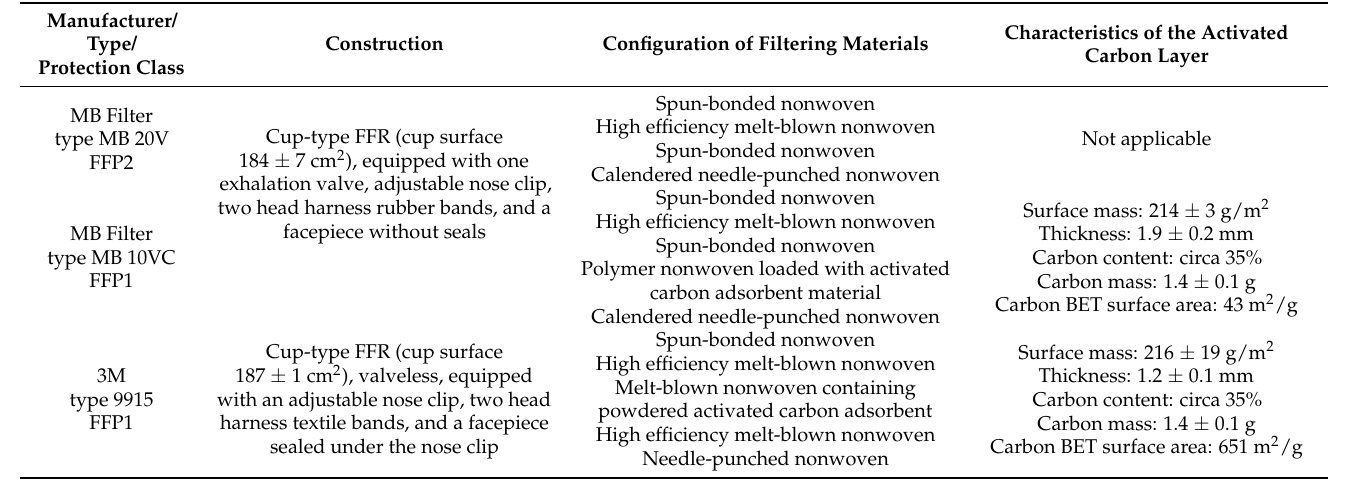
Table 1. The characteristics of FFRs.